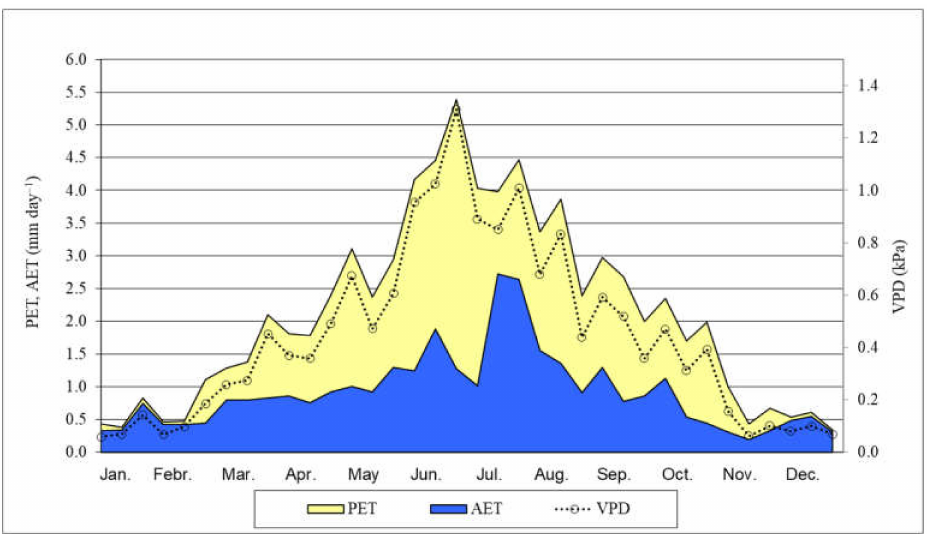
Figure 2. Potential (PET) and actual (AET) evapotranspiration, AET/PET ratio (%) and VPD in black locust (Napkor, 2021). Average of the decades. VPD: Vapor pressure deficit, calculated using meteorological data.